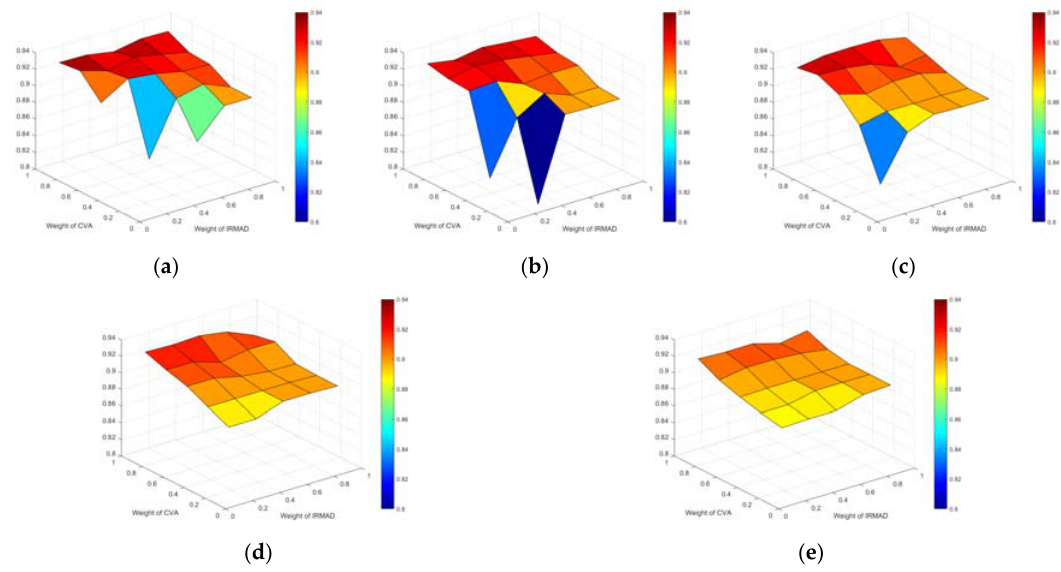
Figure 8. The quantitative evaluation with the ISFA weight of ( a ) 0.1; ( b ) 0.3; ( c ) 0.5; ( d ) 0.7; and ( e ) 0.9 in test dataset 1.